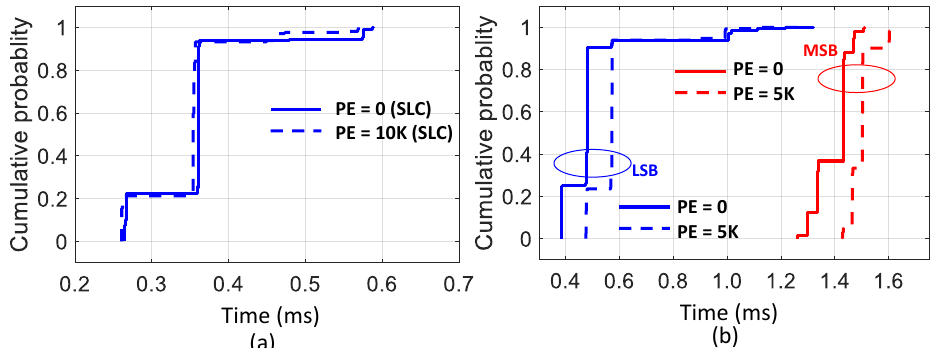
Figure 12. ( a ) Cumulative distributions of page program times for SLC pages in fresh (solid blue line) and 10K-PE-cycle (dashed blue line) conditions. ( b ) Cumulative distribution of page program time for LSB pages in fresh (solid blue line) and 5K-PE-cycle (blue dashed line) conditions, and MSB pages in fresh (solid red line) and 5K-PE-cycle (dashed red line) conditions.